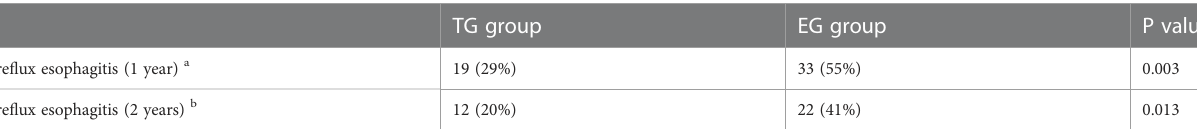
TABLE 7 Rate of re fl ux